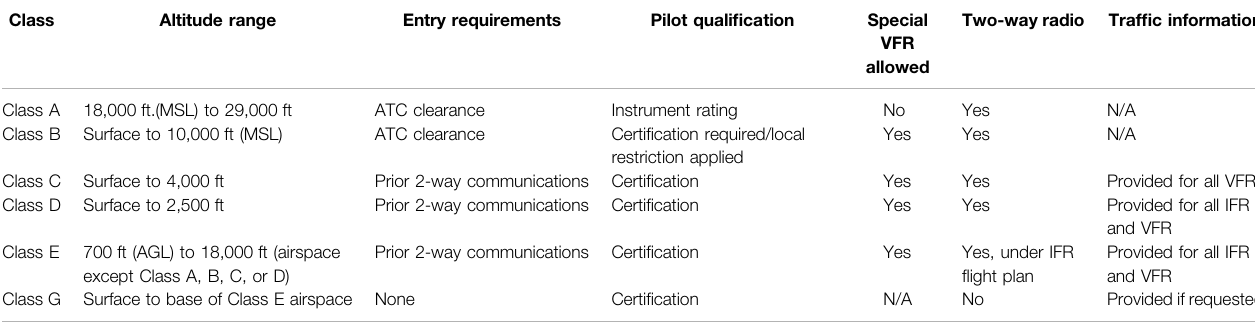
TABLE 4 | Summary of airspace